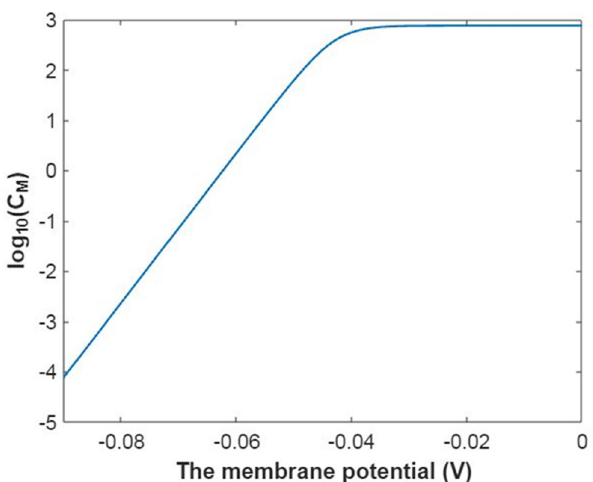
Figure 3. The relationship between membrane potential and the common logarithm of the membrane conductance of sodium ions according to the Boltzmann distribution at G = − 6.33 J and over membrane potential range from − 0.09 V to 0 V.